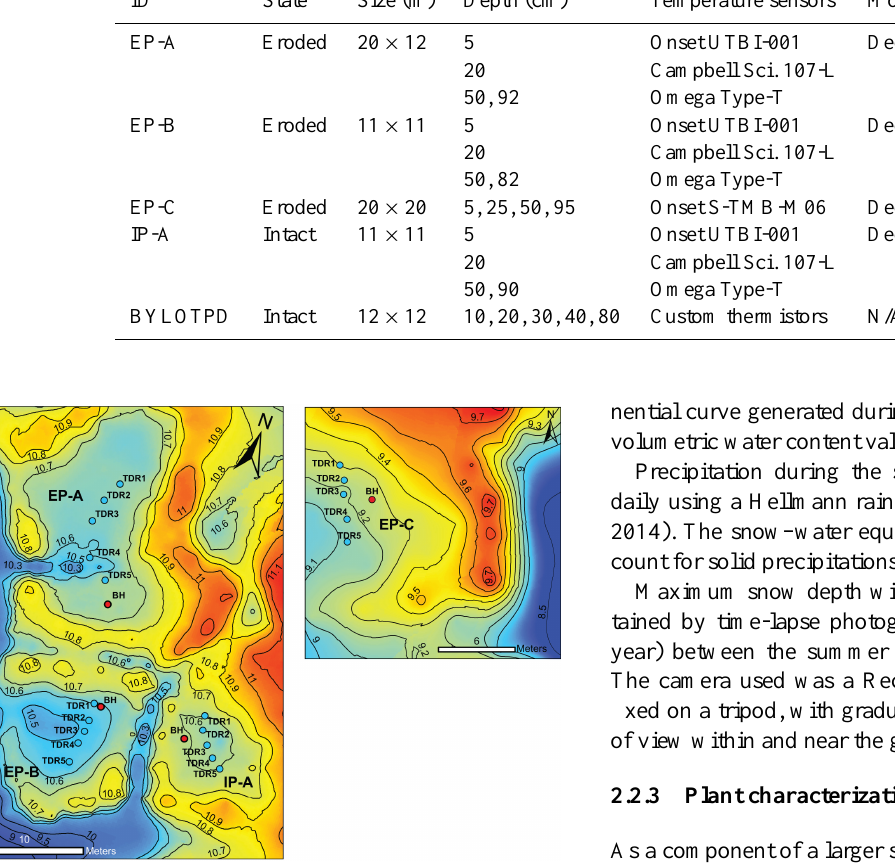
Figure 3. Digital elevation model of sites EP-A, EP-B, EP-C and IP-A. Altitudinal isoline contours were digitized on the figure at each 0.1m. A gully channel (deep blue) was initiated in 1999 near the polygons; rims (yellow and orange) delineate polygon contours; light blue indicates a breach by erosion in EP-A, EP-B and EP-C. The IP-A ridge contouring the polygon is intact. The gully channel floor (dark blue) is approximately 2m lower than nearby polygons’ rims at this position. Boreholes equipped with a string of thermistors (BH in the figure) are identified in red in each polygon and moisture sensors are identified in blue (TDR in the